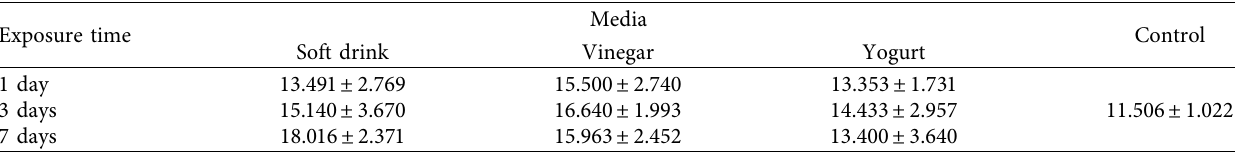
Table 5: Crystallinity index based on FWHM of 604cm − 1 (mean ± SD) for the dentin of tooth samples after exposure to different media at variable times, including the control group.